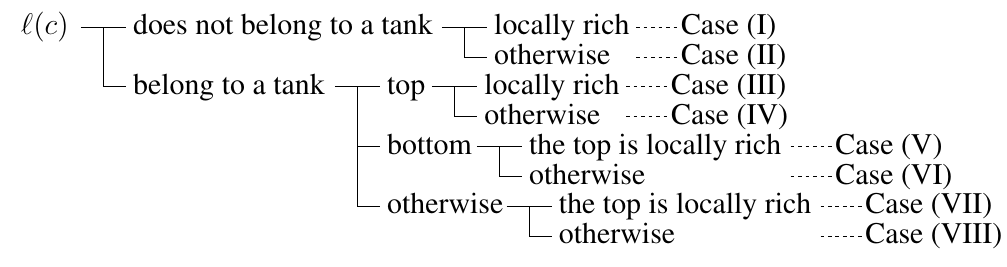
Figure 7. Execution of E XTENDED -L AZY for a deletion d